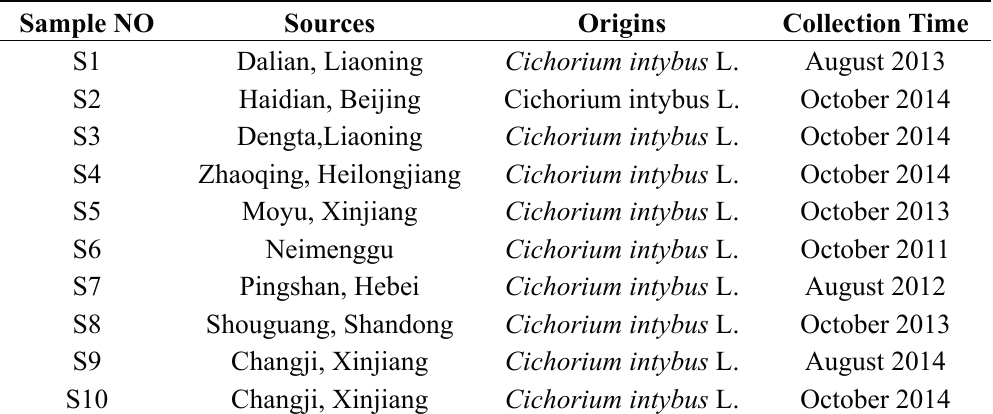
Table 4. Raw herbs used in this